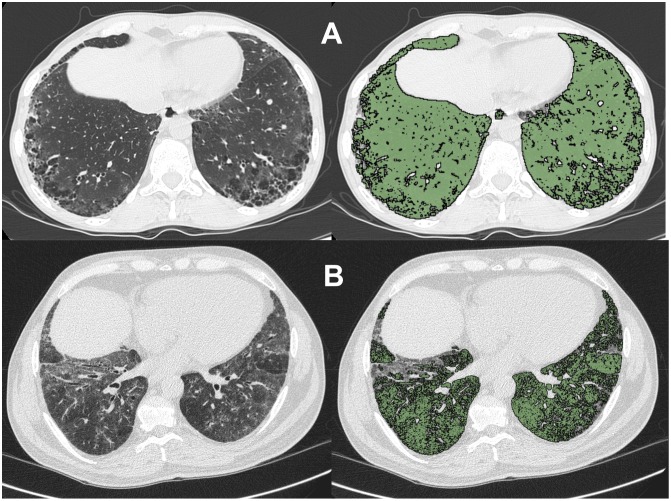
Representative sequences of the OsiriX segmentation process of two study participants.(A) Patient with mild (13%) of pulmonary fibrosis. (B) Patient with severe (41%) pulmonary fibrosis. We have developed the pulmonary fibrosis fraction by the following formula: total HRCT lung volume (−1.024 to −200)–nonfibrotic HRCT lung volume (−1.024 to –700) divided by total HRCT lung volume (−1.024 to −200) multiplied by 100.